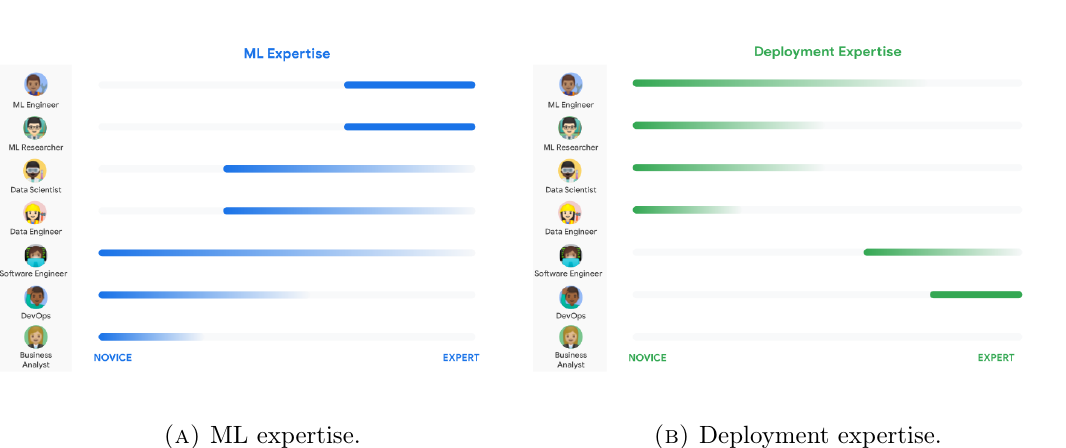
Figure 8. Machine learning (ML) personas. Many different people are involved to realize ML-enabled applications in the real world. It is important to understand this big picture to appreciate the role that everyone places in a successful ML use